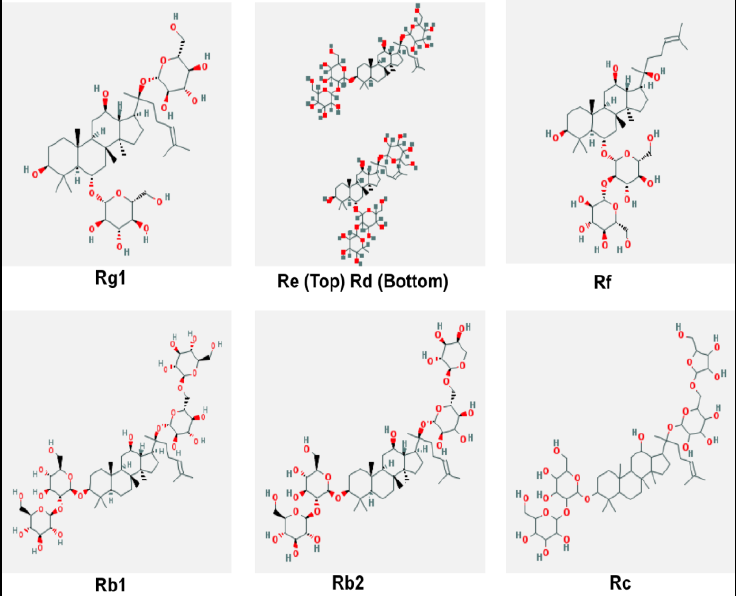
Figure 2. Major ginsenosides of Panax ginseng. Chemical structures were taken from the PubChem Substance and Compound database (pubchem.ncbi.nlm.nih.gov).